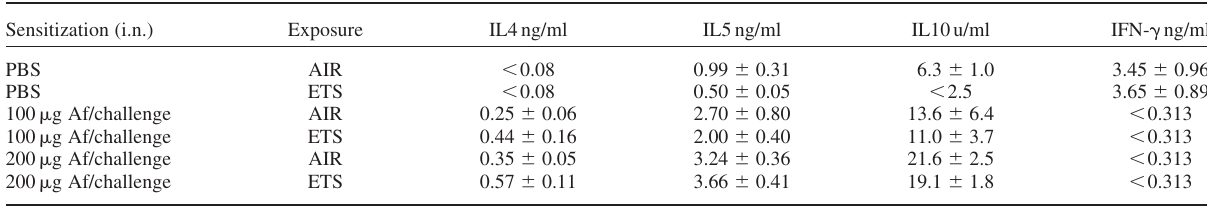
TABLE I Cytokines produced after anti-CD3 stimulation of homogenized lung cells from Af sensitised and control mice Sensitization